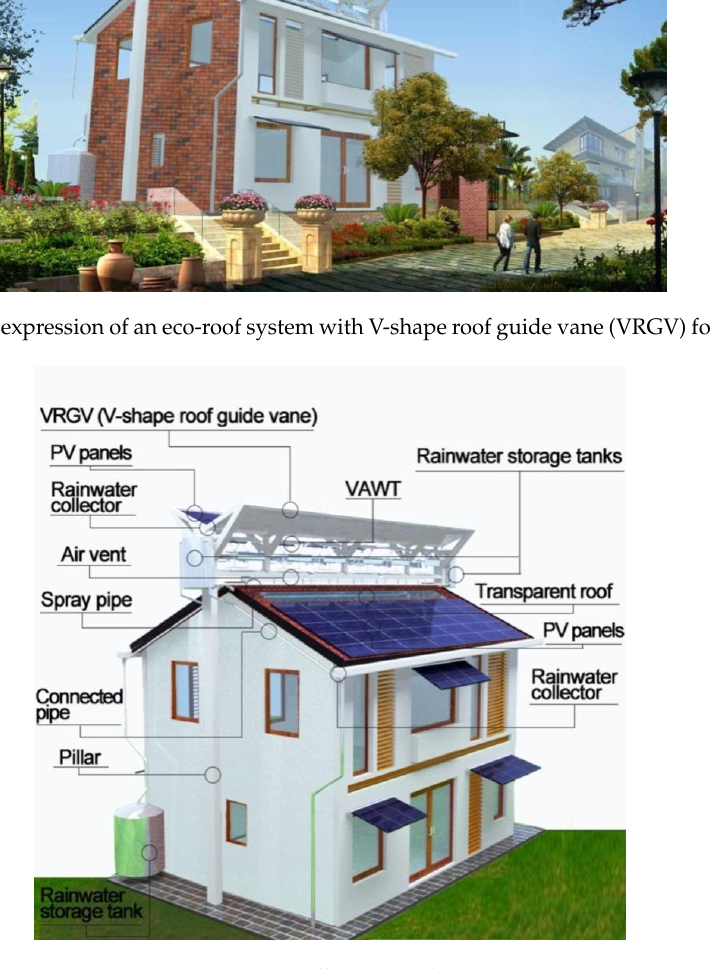
Figure 4. Overall structure layout. 2. Concept Design of an Eco-Roof System with V-Shape Roof Guide Vane (VRGV)